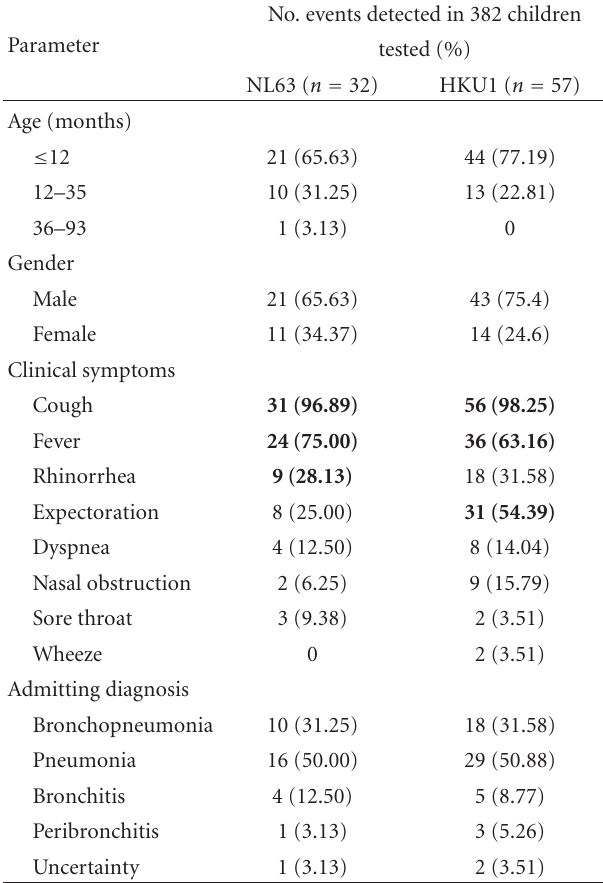
Table 1: HCoV-NL63 and HCoV-HKU1 detection in 382 children with acute respiratory infections in Beijing, China, May 2008 to March 2010. Age, gender, and clinical details are listed for those positive for either